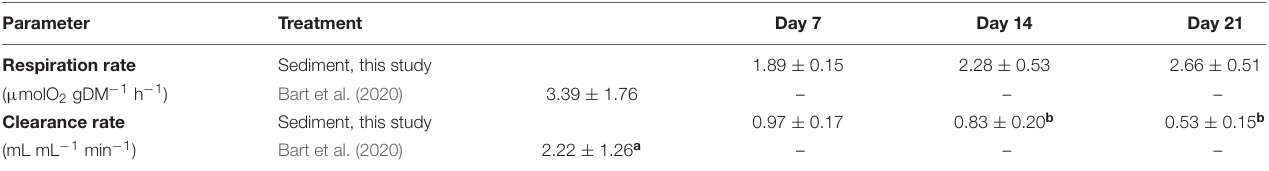
TABLE 1 | Overview of the assessed physiological parameters in Vazella pourtalesii under elevated concentrations of suspended particles (Sediment, n = 5) and the literature control group ( n = 7) (Bart et al., 2020). Parameter